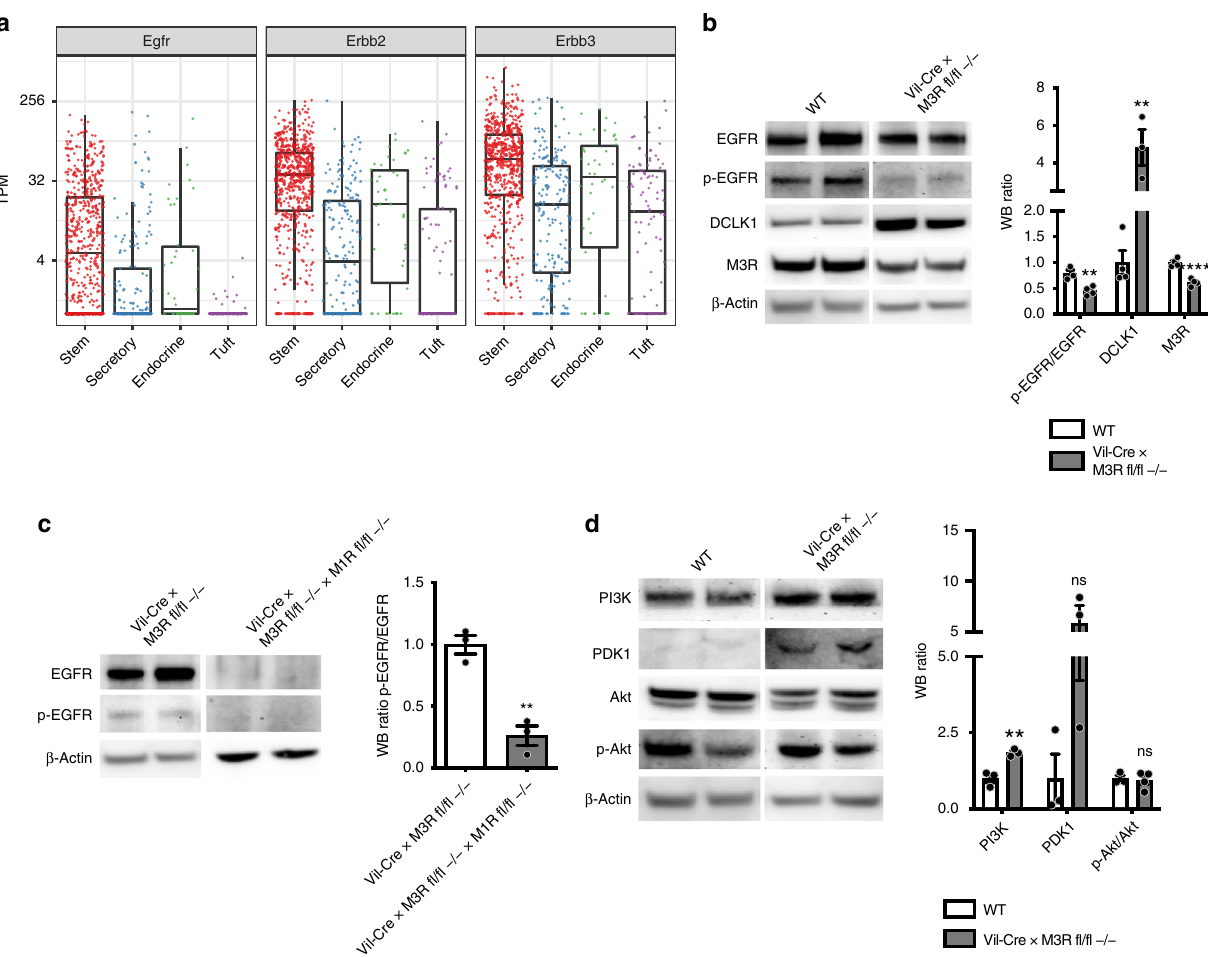
Fig. 5 Cholinergic niche sustains compensatory PI3K signaling following epithelial cholinergic receptor ablation. a EGFR , Erbb2 , and Erbb3 expression in intestinal single cells 13 ; TPM transcripts per kilobase million. b Immunoblot analyses of epithelial-enriched Vil-Cre × M3R fl / fl mouse samples for p-EGFR/EGFR, DCLK1, and M3R ( n = 3 WT mice p-EGFR/EGFR; 4 WT mice DCLK1, M3R; n = 4 Vil-Cre × M3R fl / fl − / − p-EGFR/EGFR, M3R; 3 Vil-Cre× M3R fl / fl − / − mice DCLK1; WT p-EGFR/EGFR Mean = 0.783, SEM = 0.073; DCLK1 Mean = 1, SEM = 0.234; M3R Mean = 1, SEM = 0.04; Vil-Cre × M3R fl / fl p-EGFR/EGFR Mean = 0.45, SEM = 0.043; DCLK1 Mean = 4.827, SEM = 0.95; M3R Mean = 0.612, SEM = 0.036; multiple t tests; p-EGFR/EGFR t